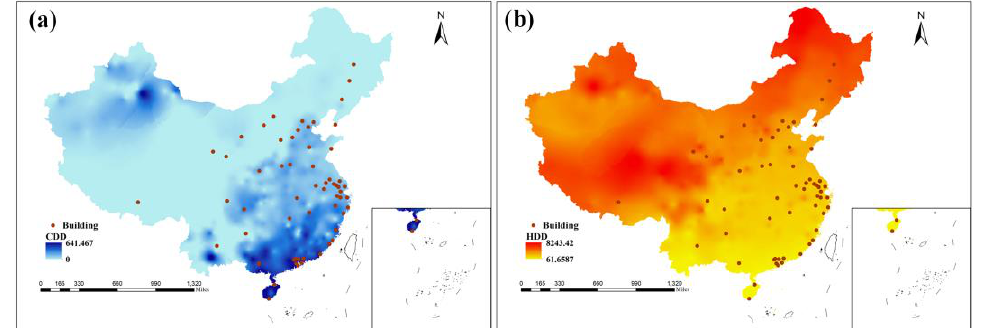
Figure 3. Regional climate values for the selected buildings. ( a ) CDD of selected building locations; ( b ) HDD of selected building locations. (Note: CDD represents cooling degree days. HDD represents heating degree days. The unit of CDD and HDD is °C·day).